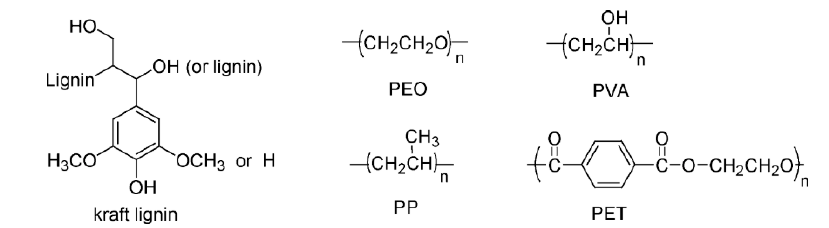
Figure 14. Structural representations of the various polymeric materials that can be blended with lignin [45].